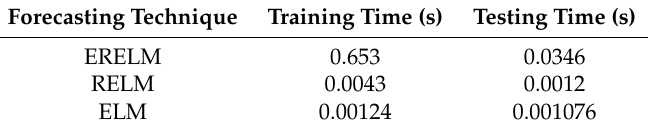
Table 12. Computational time comparison of ERELM, RELM and ELM execution.